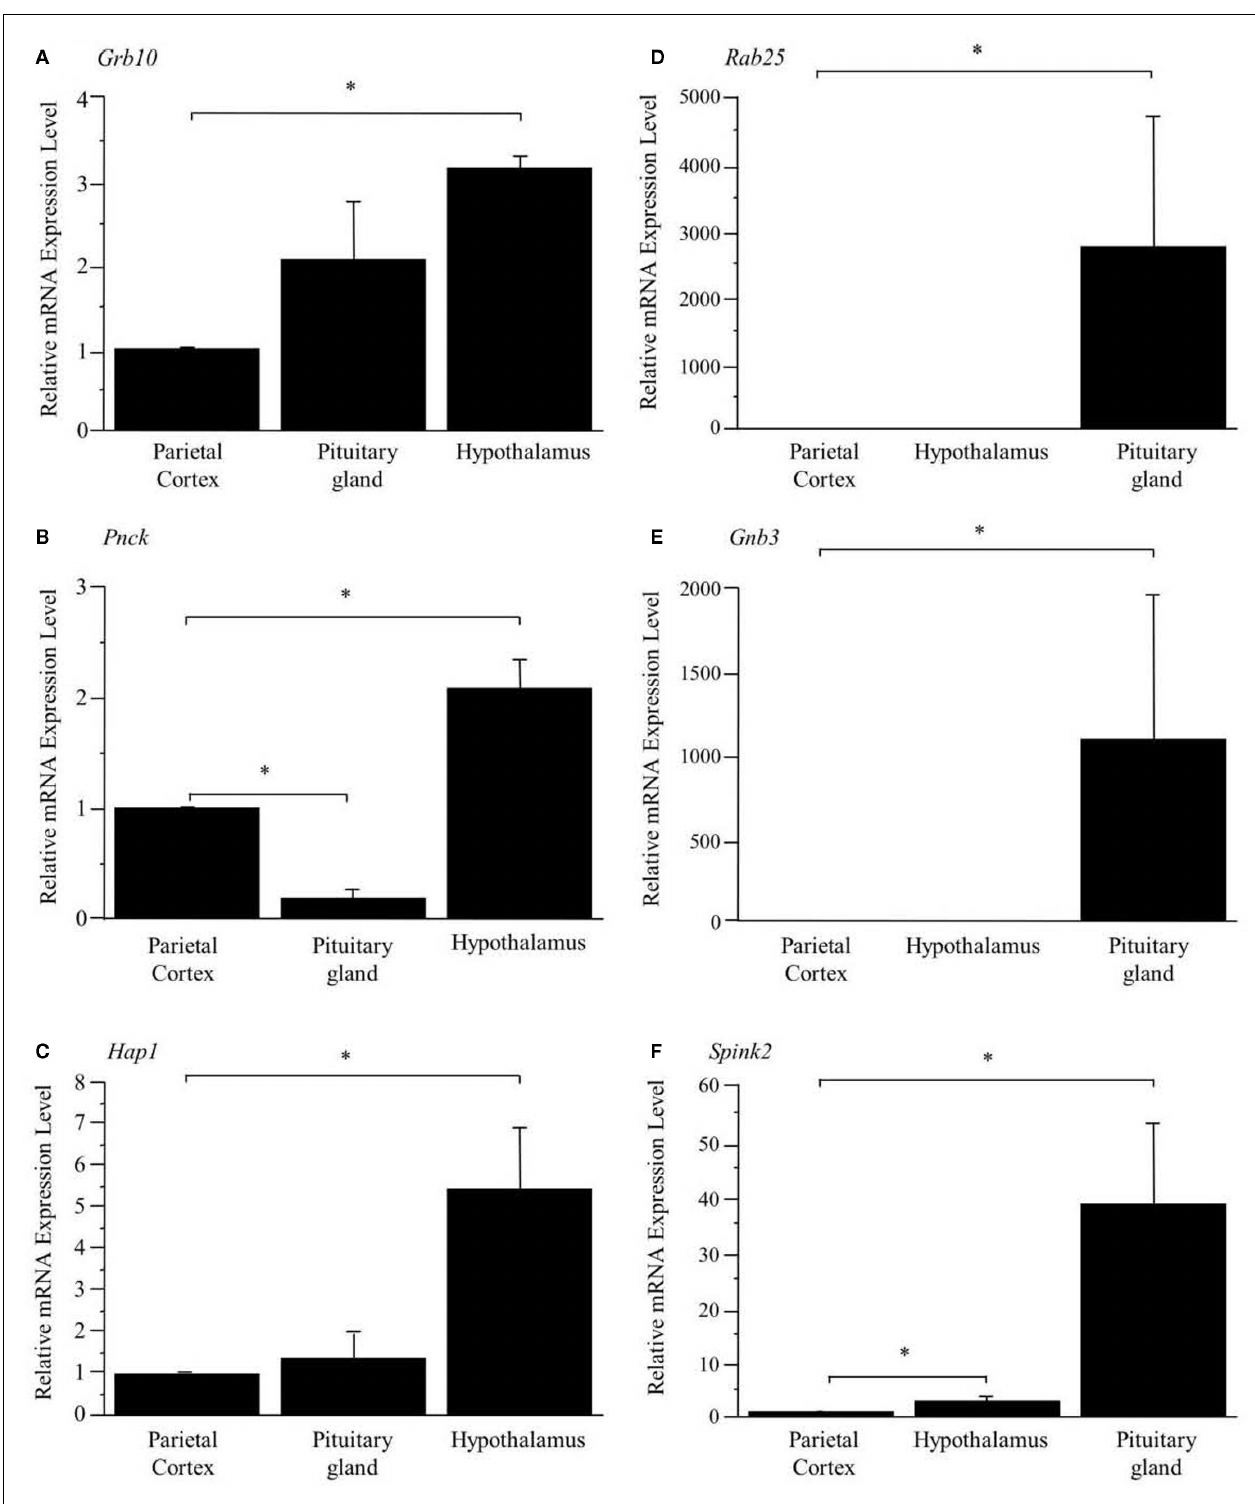
FIGURE 1 | Confirmation of preferentially expressed genes in the hypothalamus (A–C) and pituitary gland (D–F). The expression levels are normalized to Hprt and are shown as fold difference compared with the parietal cortex. *Represents a significant difference compared to the parietal cortex ( p < 0.05). Data are represented as mean ±